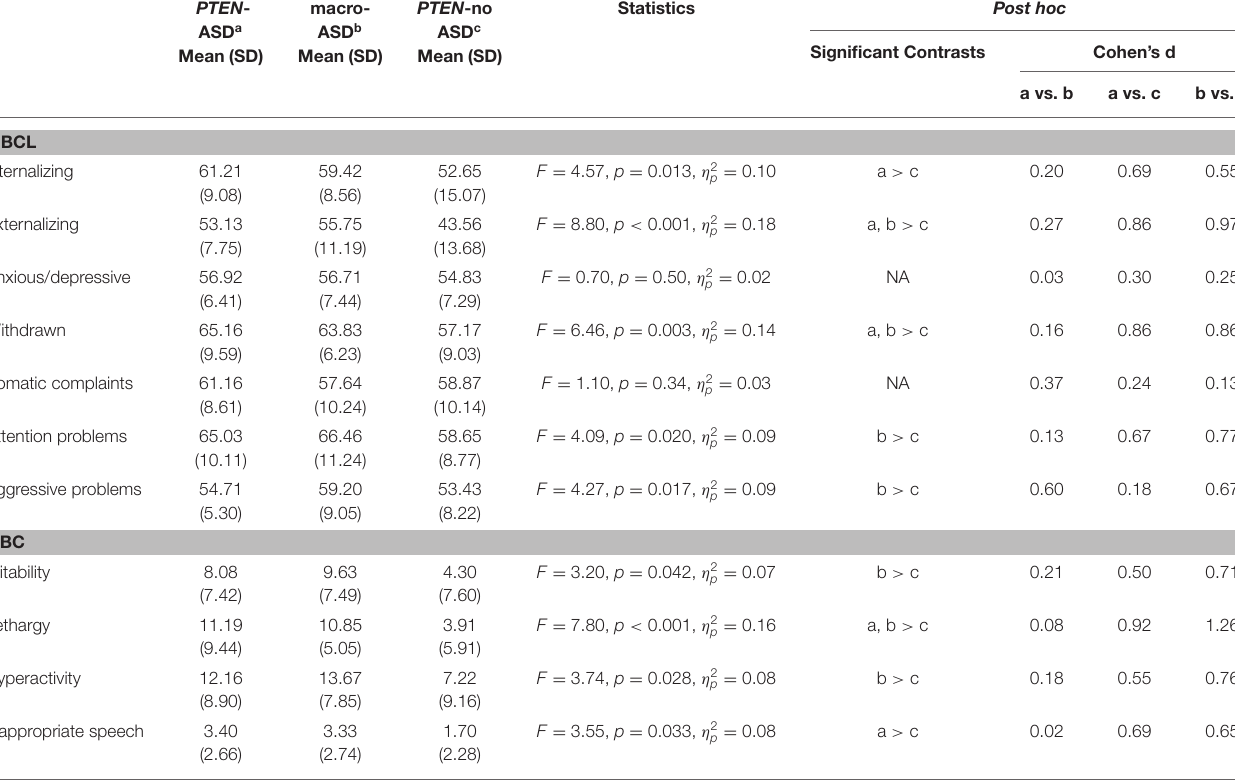
Statistics Post hoc